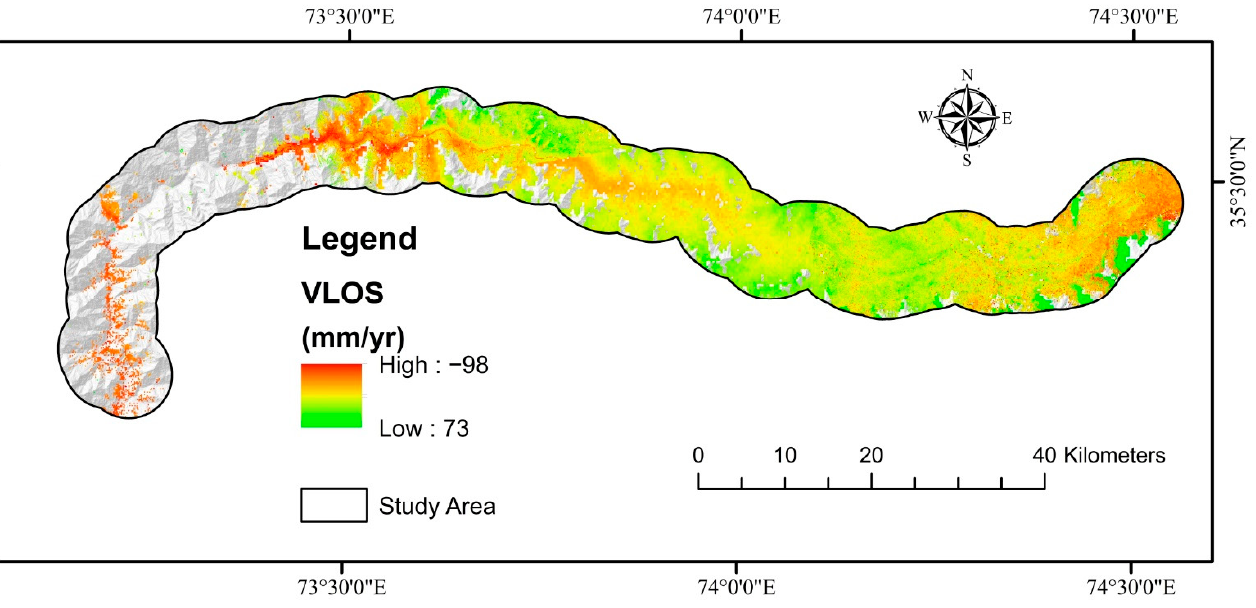
Figure 12. Landslide deformation velocity map along LOS direction for ascending and descending paths using PS-InSAR.